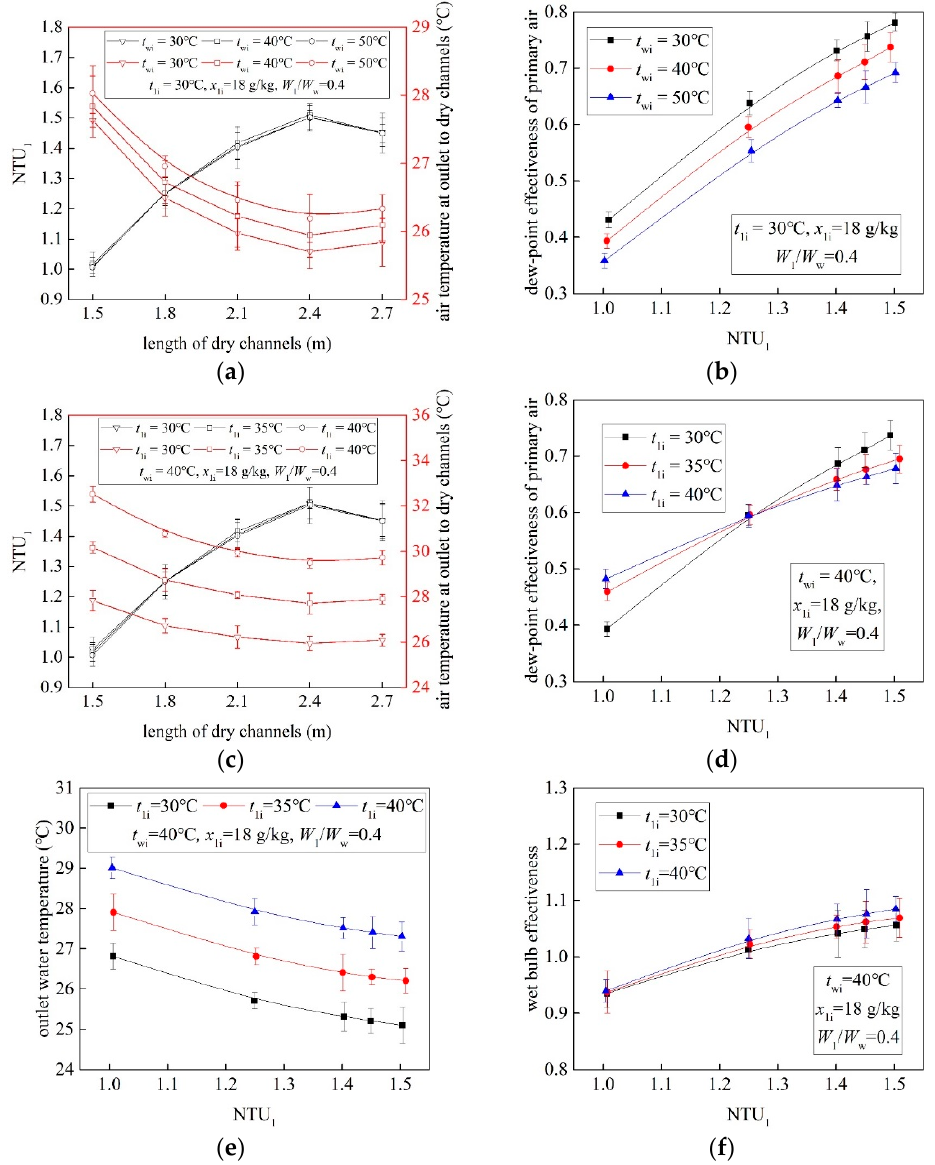
Figure 6. Impact of structural parameters on the performance of the MCT: ( a ) l dry vs. NTU 1 and t wo ; ( b ) NTU 1 vs. ε DP1 ; ( c ) l dry vs. NTU 1 and t 1o ; ( d ) NTU 1 vs. ε DP1 ; ( e ) NTU 1 vs. t wo ; ( f ) NTU 1 vs. ε WB .